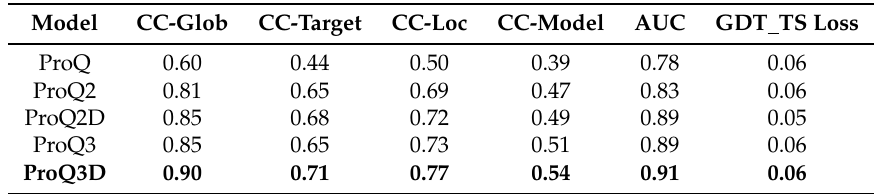
Table A1. Performances of the ProQ models in CASP11 [58].